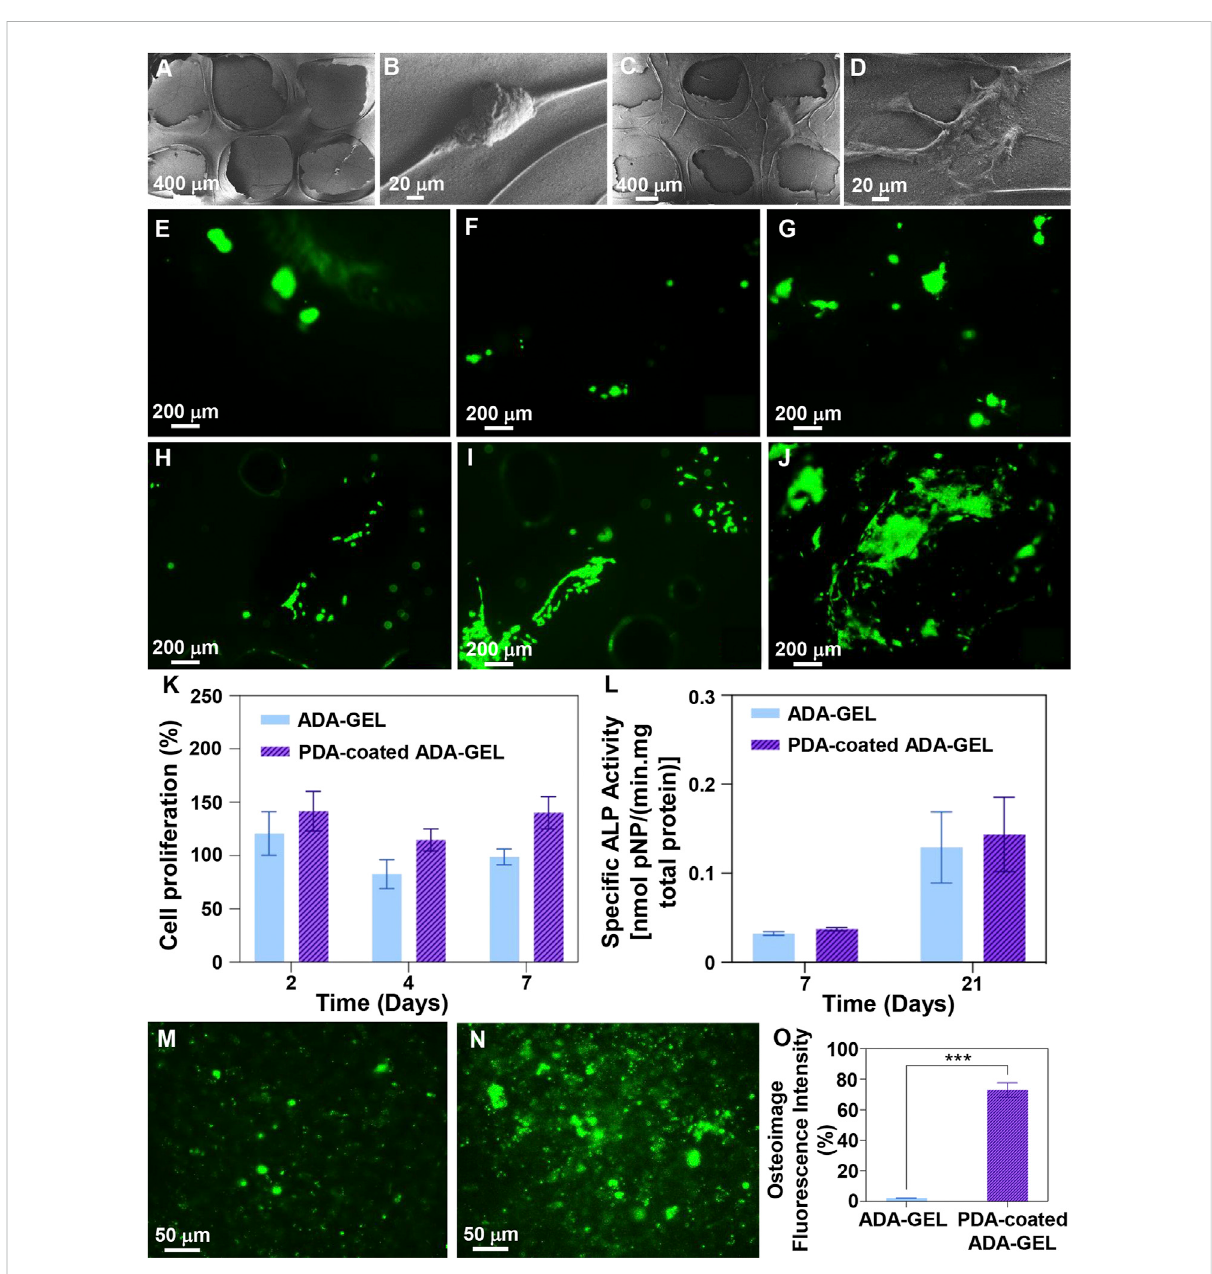
FIGURE 7 Cell-scaffolds interaction. (A – D) FE-SEM images of MG-63 cell adhesion on the surface of (A,B) ADA-GEL and (C,D) PDA-coated ADA-GEL scaffolds after 2 days culture. (E – J) MG-63 cell staining with calcein-AM after (E,H) 2, (F,I) 4, and (G,J) 7 days culture on (E – G) ADA-GEL and (H – J) PDA-coated ADA-GEL scaffolds, indicating cell viability. (K) Proliferation of MG-63 cells on the scaffolds as a function of incubation time. (L) ALP activity of MG-63 cells on the scaffolds after 7 and 21 days of culture. (M – O) Osteoimage mineralization of (M) ADA-GEL and (N) PDA-coated ADA-GEL scaffolds and (O) related quantitive results after 21 days cell culture. Differences are considered considerably signi fi cant (*** p <